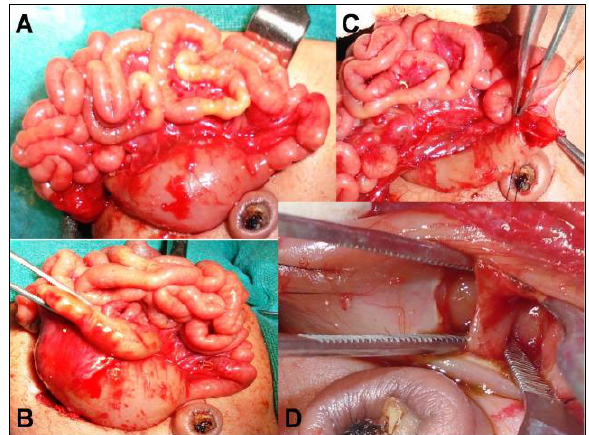
Figure 2: Intra-operative images depicts dilated duodenum and increased wall thickness till DJ junction (transition zone) with complete exposure of the DJ junction (A,B); enterotomy at DJ junction revealing web (C,D).